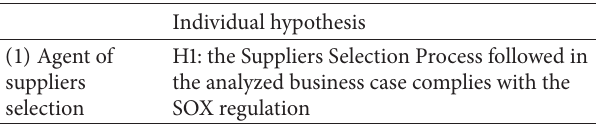
Table 16: Agent’s